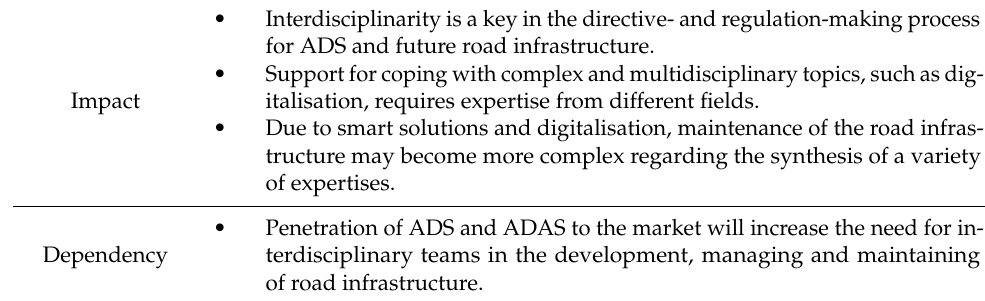
Table 13. Summary of the impacts and dependencies of interdisciplinarity.